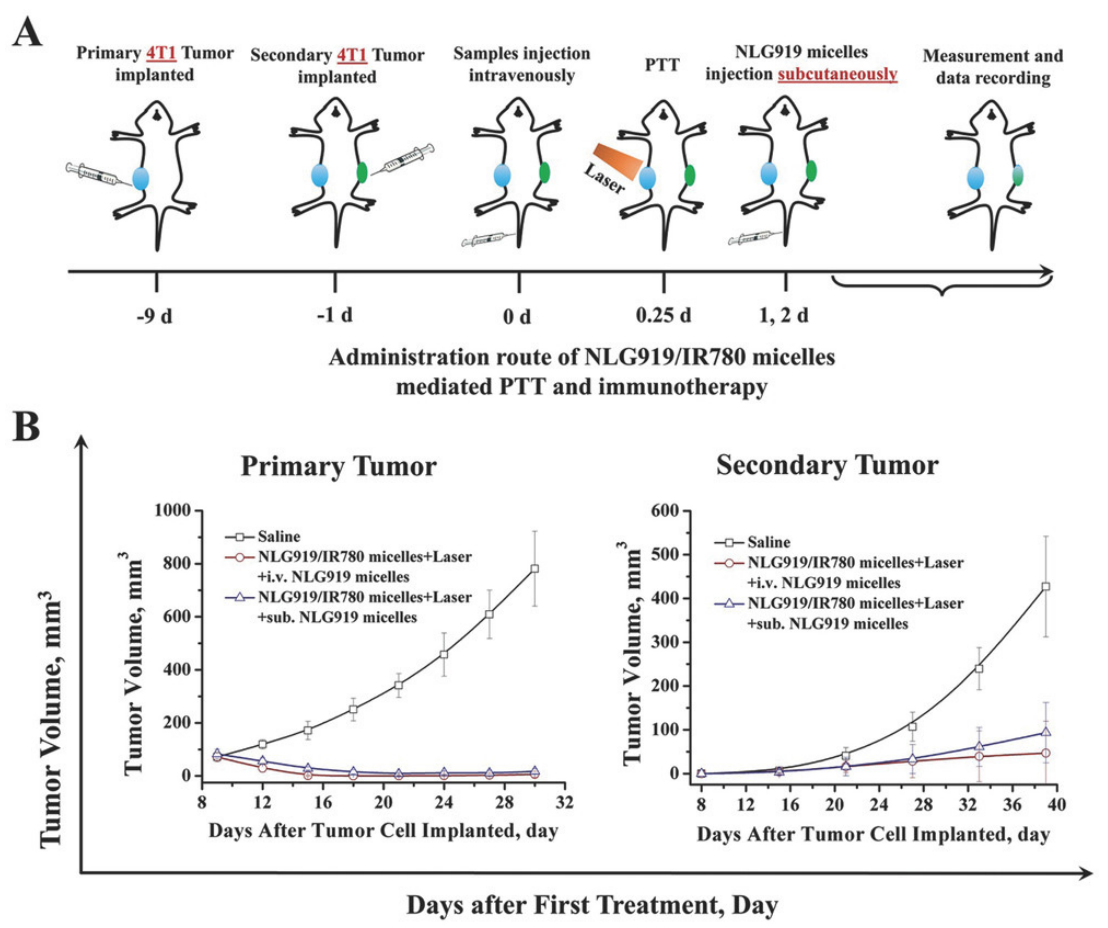
Figure 6. Immuno-PTT mediated by PEG-PCL micelles-loaded with NLG919 and IR780 in primary and secondary tumors. ( A ) Schematic representation of the treatment schedule; ( B ) Primary and ( B ) Secondary tumor volumes after different treatments. Reprinted with permission from [106]. Copyright 2018 Wiley. NLG919/IR780 micelles: PEG-PCL micelles-loaded with NLG919 and IR780; NLG919 micelles: PEG-PCL micelles-loaded with NLG919; i.v.: intravenous administration; sub.: subcutaneous administration; Laser: NIR light irradiation.